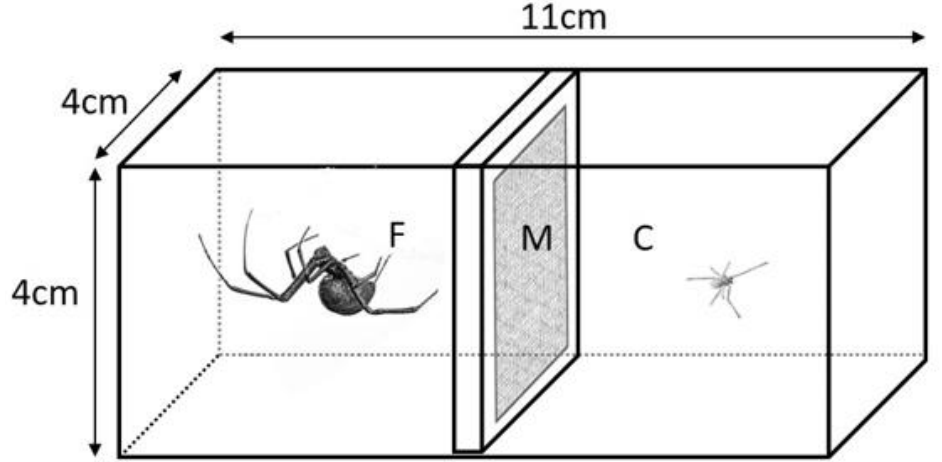
Figure 1. Cohabitation cages consisted of two clear plastic chambers bisected by a porous material (M, light-weight non-fusible interfacing) in a plastic frame that allowed the passage of airborne chemicals and vibrations between the chambers, but did not allow direct contact between the spiders when they were in opposite chambers. The focal subadult females (F) were held with a cohabitant (C, adult male [shown] or juvenile female), or the adjacent chamber was left empty (isolation control). The spider images (not to scale) are from photographs by Ken